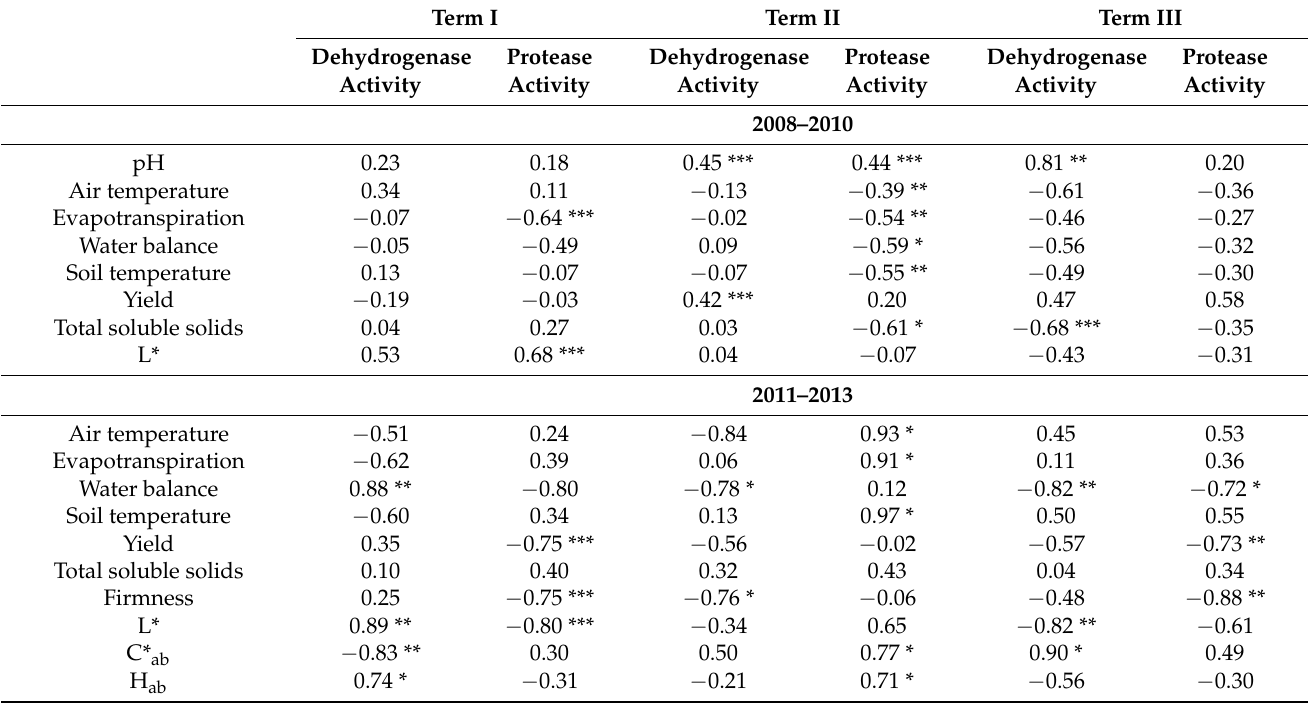
Table 6. Value of linear correlation